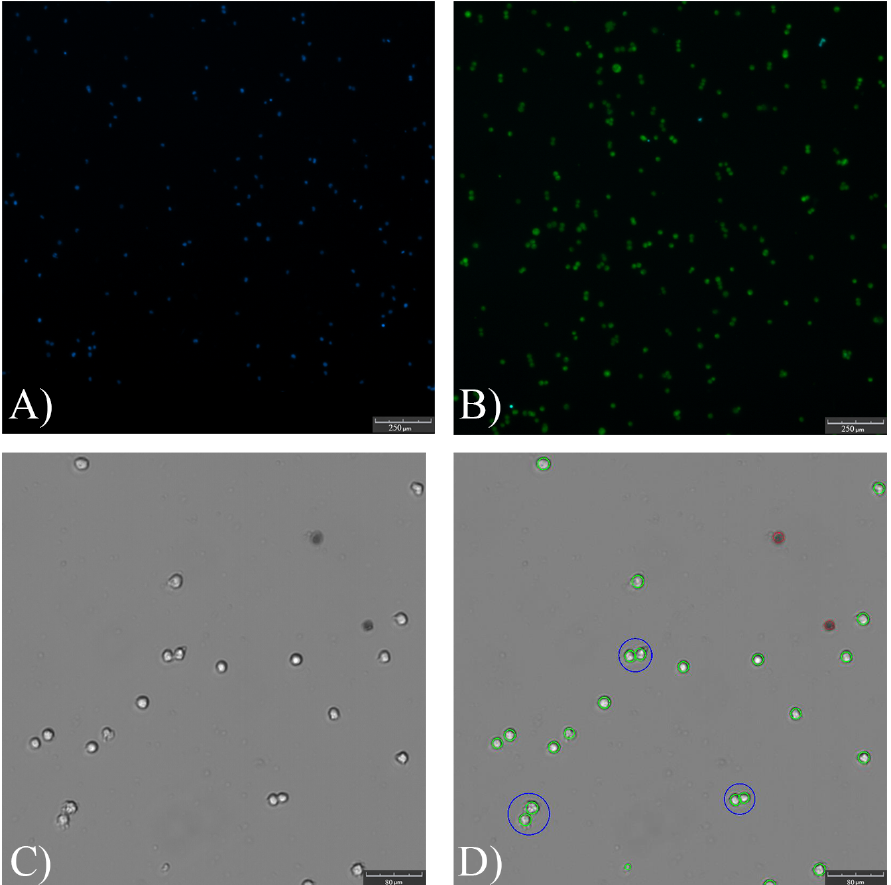
Figure A1. Viability analysis of HEK293 suspension cells cultivated in a baffled 500mL shake